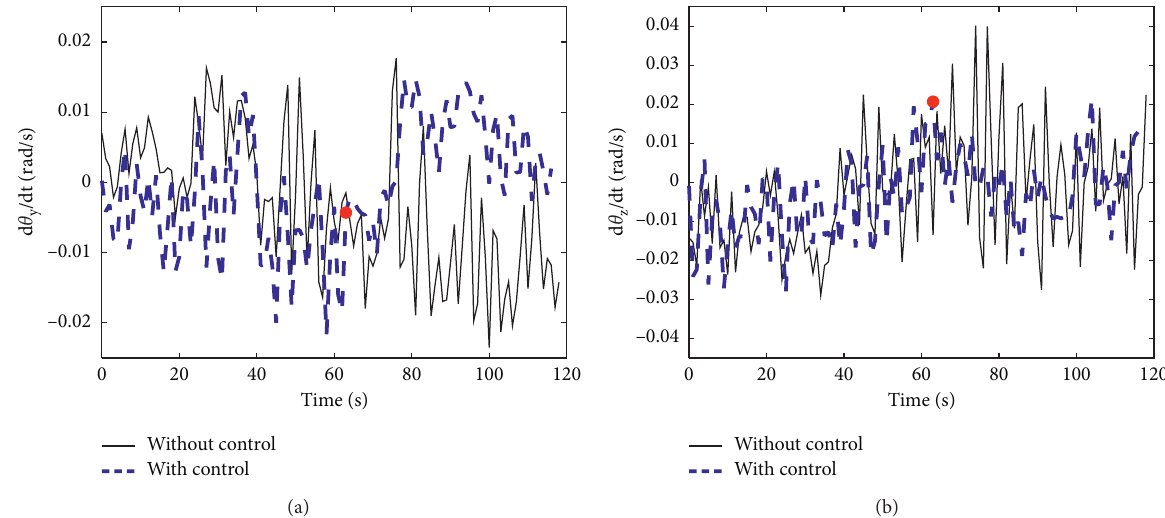
Figure 14: Experimental results of the elevation part in launching process for the 3rd rocket: (a) the yawing angular velocity and (b) the pitching angular velocity. The red dots indicate the action of the AAT.